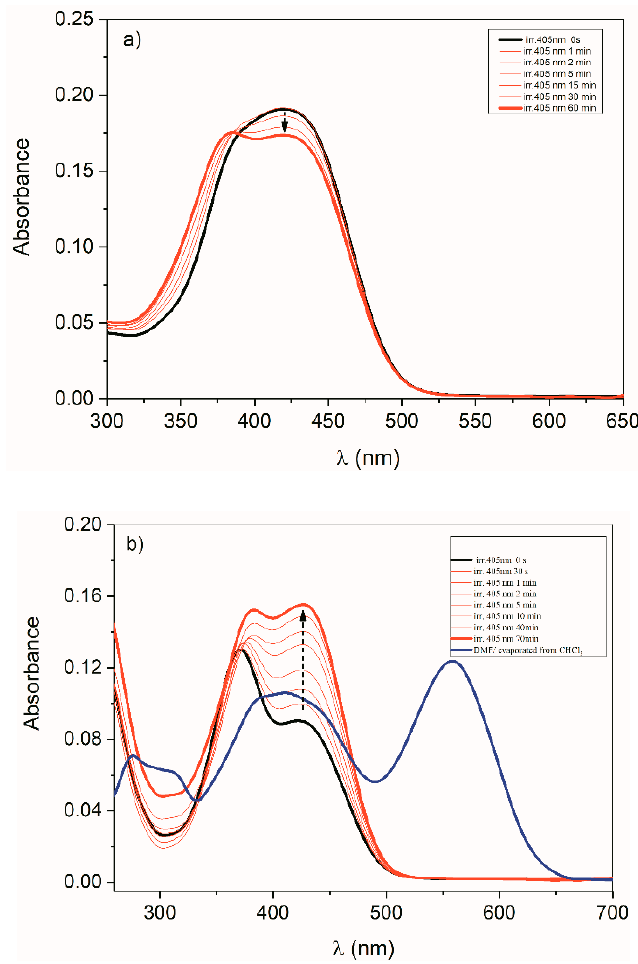
Figure 4. Photoisomerization of hydrazone 3 E - and Z -isomer (1 × 10 − 5 mol · dm − 3 ) in CHCl 3 : ( a ) Z -isomer; ( b ) E -isomer.